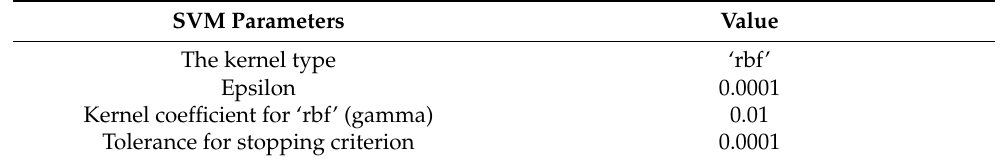
Table 3. The Support-vector machines (SVM) model parameters.